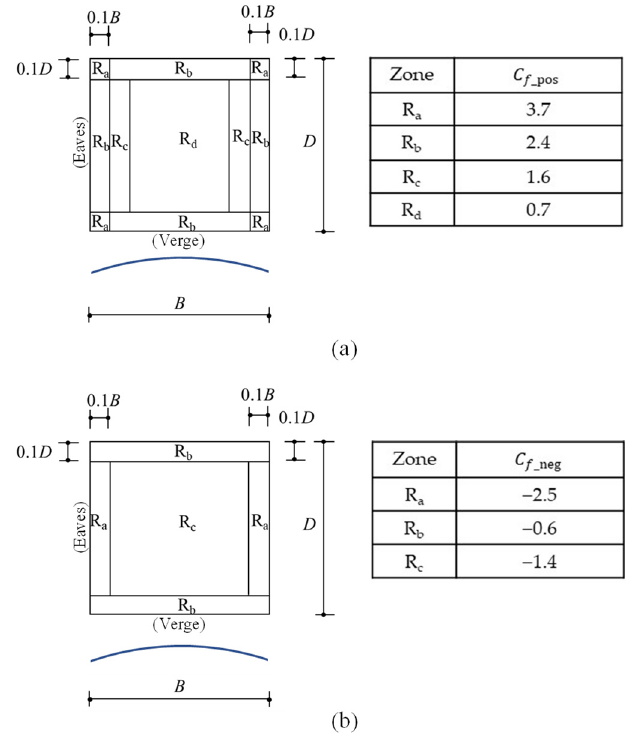
Figure 17. Positive and negative peak wind force coefficients for designing cladding: ( a ) Positive peak wind force coefficient; ( b ) negative peak wind force coefficient.